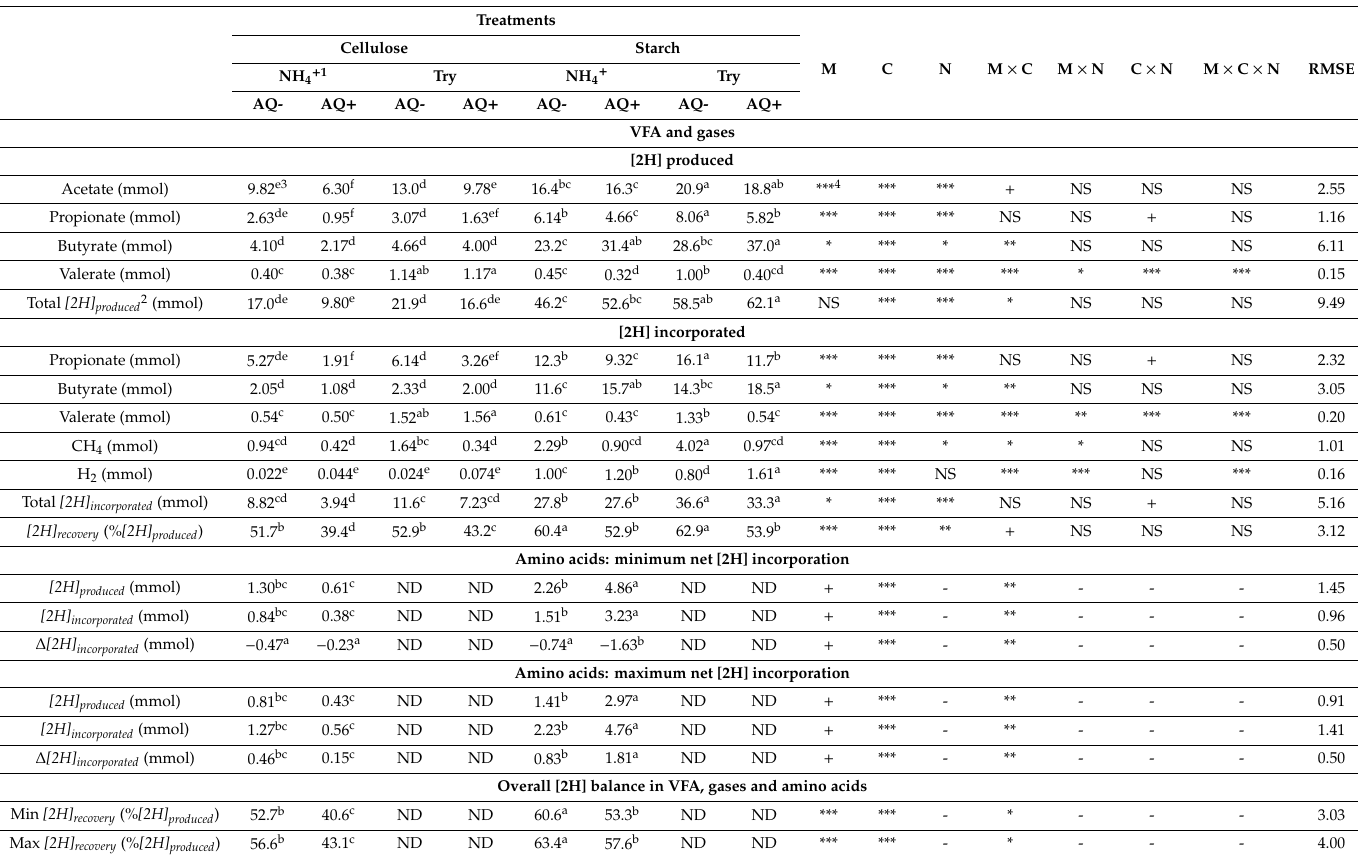
Table 4. E ff ects of the addition of 9, 10-anthraquinone to rumen batch cultures incubated with cellulose or starch as carbon and energy sources and ammonium or trypticase as sources of nitrogen on the metabolic hydrogen